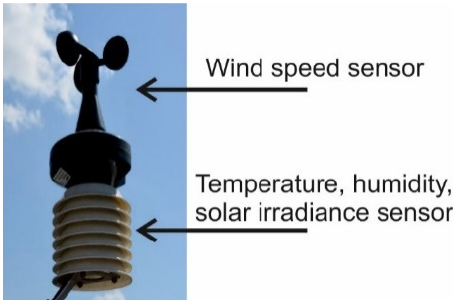
Figure 6. Description of sensors in the weather station.